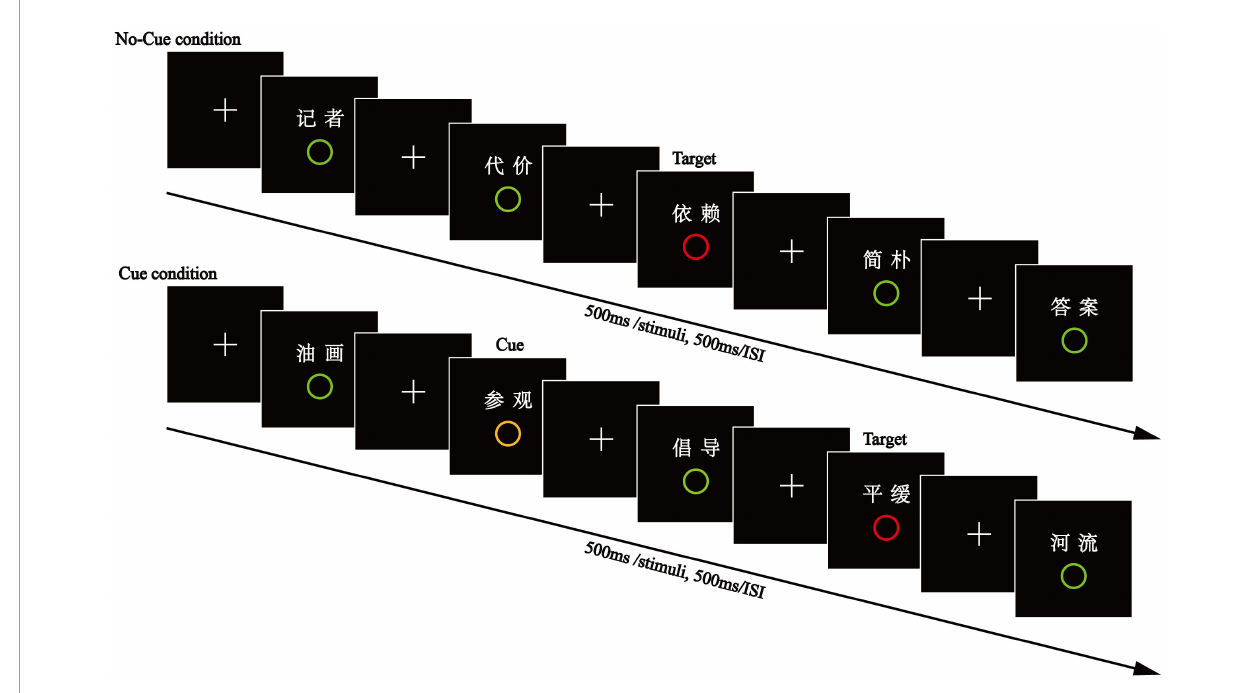
FIGURE3 The encoding phase of Experiment 2. Between the cue- and target-paired words was inserted a word paired with a middle-distractor circle.